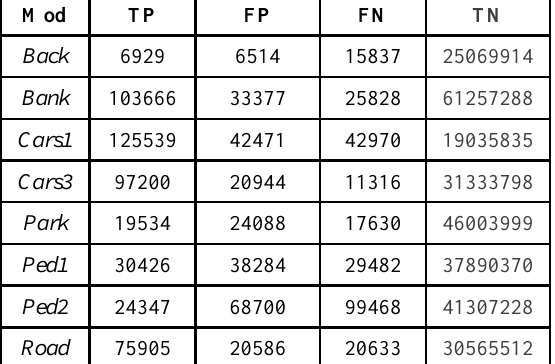
Table 3. Modified algorithm results for each video in terms of